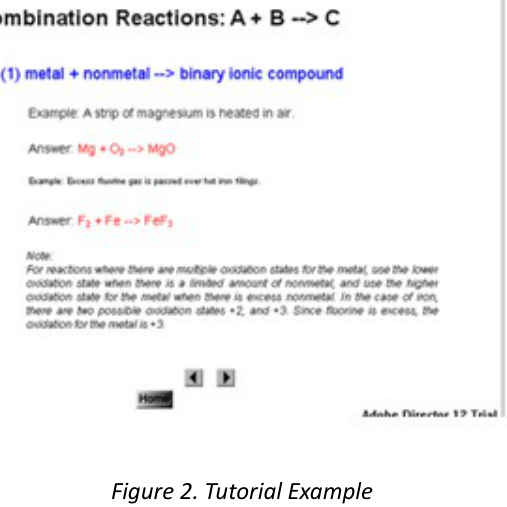
Figure 2. Tutorial